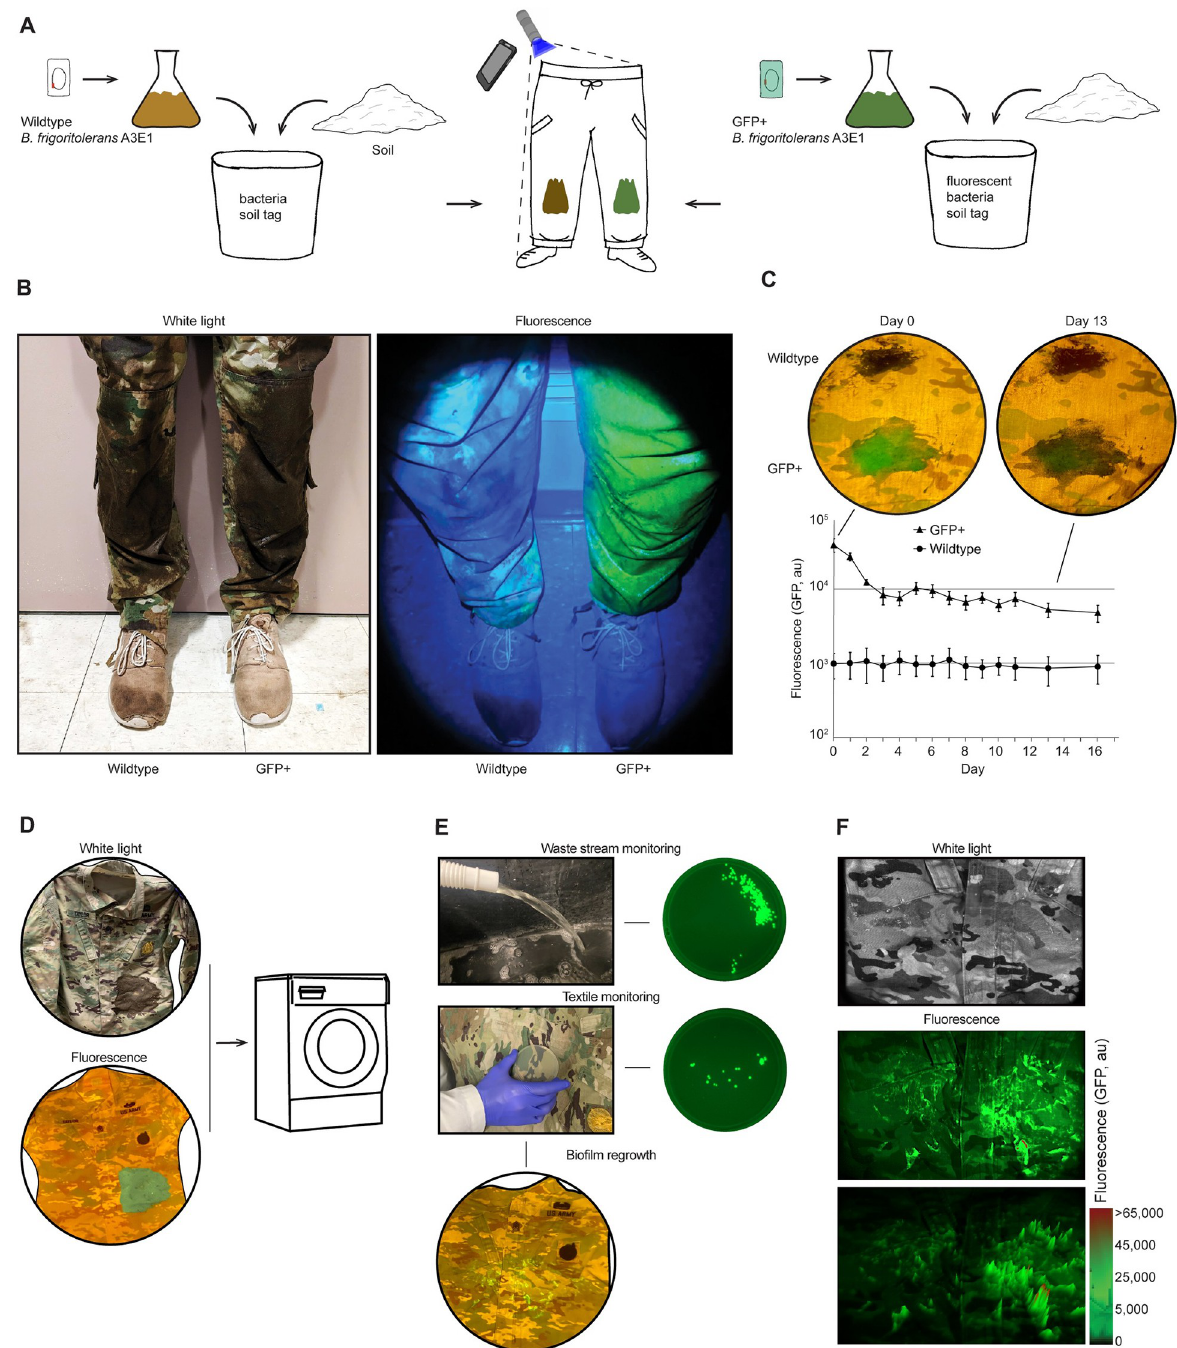
Fig 3. Applications for bacteria-infused soil on textiles. (a) Schematic of the application (b) Cell-phone pictures of trousers after smearing with WT (right leg) and GFP+ (left leg) B . frigoritolerans A3E1, under white light (left) and fluorescence imaging using Blue LED flashlight (450 nm) and 505 nm filter taped to the camera (right). (c) The stability of GFP+ B . frigoritolerans A3E1 fluorescence applied over time measured using a fluorescence imager to quantify the mean fluorescence of an area of the textile. Error bars represent the standard deviation of all pixels within the area. Inset represents the fluorescent images of the textile tagging, taken each day using a cell-phone camera. (d) Representative white light and fluorescence images, using a cell phone camera, of the GFP+ B . frigoritolerans A3E1 smeared textile before machine washing (e) Monitoring of smeared bacteria after washing (top) in the washing machine’s waste stream. The waste stream was sampled and spread on selective agar plates, which were incubated overnight and imaged in a fluorescence imager. (middle) Monitoring by textile imprinting using selective agar plates pressed upon the textile, incubated overnight, and imaged in a fluorescence imager. (bottom) biofilm regrowth by incubation with selective media on the